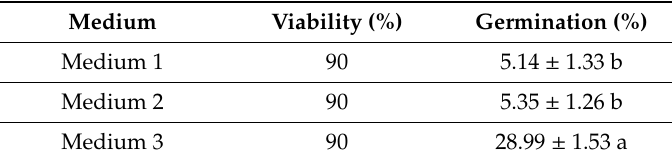
Table 4. E ff ect of di ff erent culture media on the percentage of viability and germination of fresh teak grains, previously dehydrated in silica gel for 2